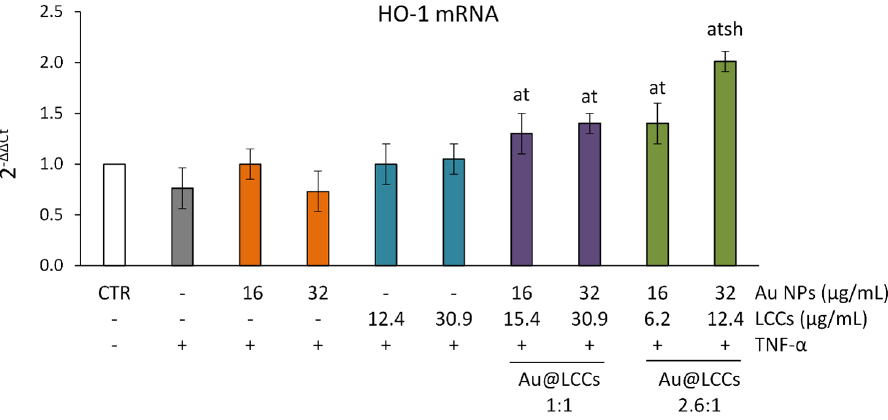
Figure 10. HO-1 gene expression in differentiated Caco-2 cells. The Caco-2 monolayers